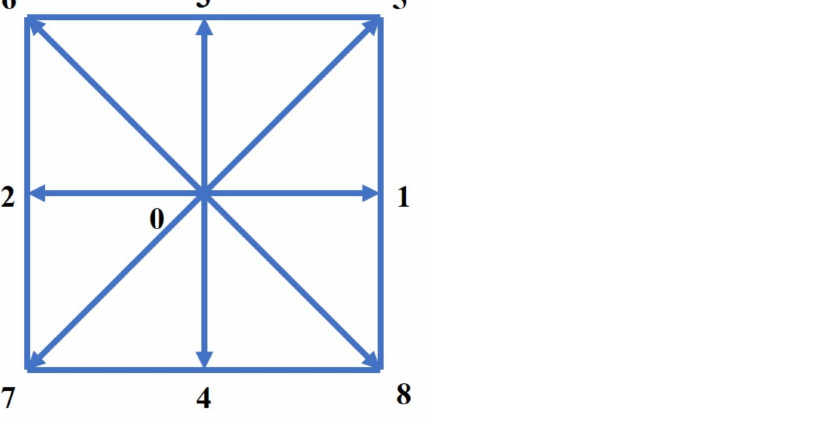
Figure 2. The D2Q9 lattice velocity model.